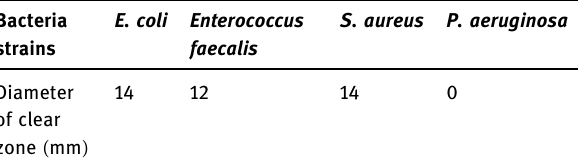
Table 2: Diameter of clear zones ( mm ) around the holes in the plates, containing synthesized ZnO NPs using autoclave heating methods and four di ff erent bacteria strains